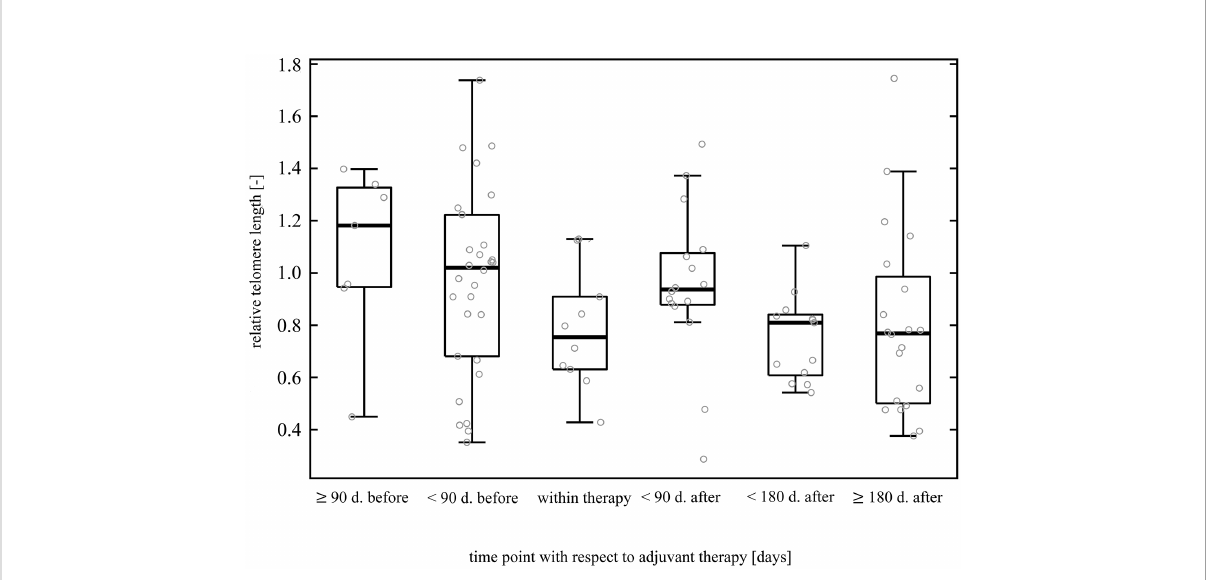
FIGURE 3 Dynamics of leukocyte telomere length before, during, and post adjuvant treatment. The data originate from patients subjected to surgery followed by adjuvant therapy. Patients with pre-operative treatment were excluded to fi lter out a possible neoadjuvant therapy in fl uence. The fi gure comprises 96 data points (samplings) without regard to patients. Forty-two patients redounded to the fi gure by at least one sampling (3 patients by one sampling, 25 patients by two samplings, 13 patients by three samplings, and 1 patient by four samplings). LTL was signi fi cantly non-uniform among the time intervals (p = 0.03), but multiple comparison test did not fi nd partcular differences between any pair of time points.